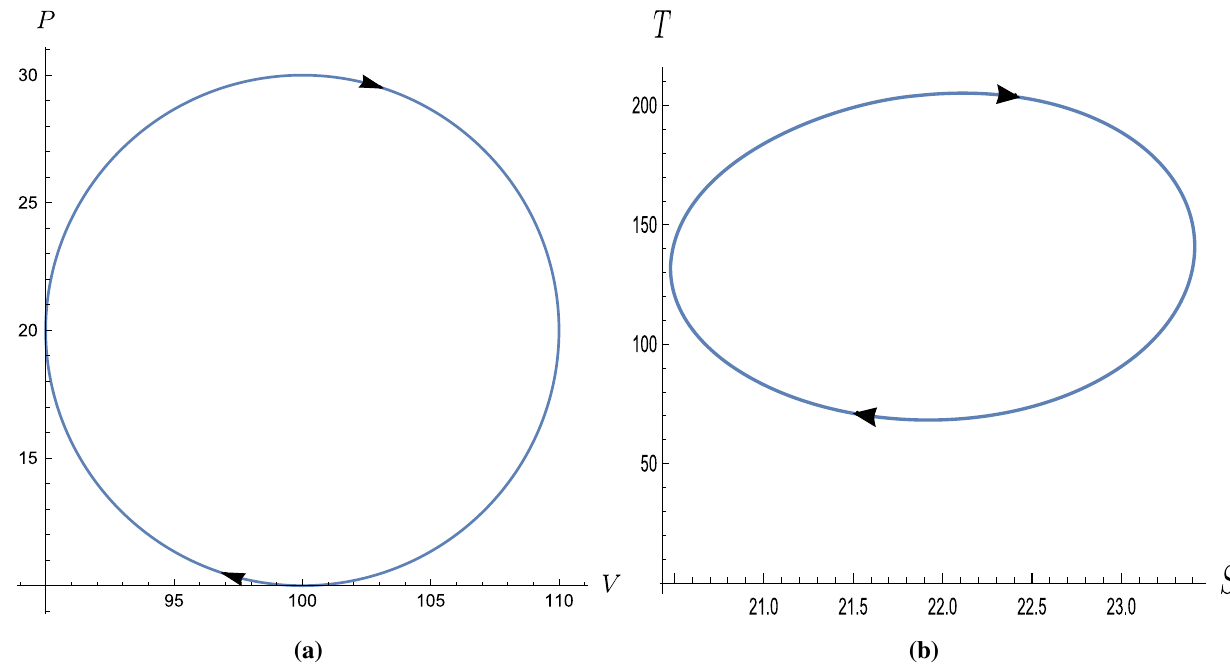
Fig. 1 For fixed tension μ − = 0 . 2, the corresponding cycle diagram of an accelerating black hole heat engine is respectively plotted in a P − V plane and b T − S plane. Here, the center of the circle in P − V plane is ( V 0 , P 0 ) = ( 100 , 20 ) with the radius R = 10